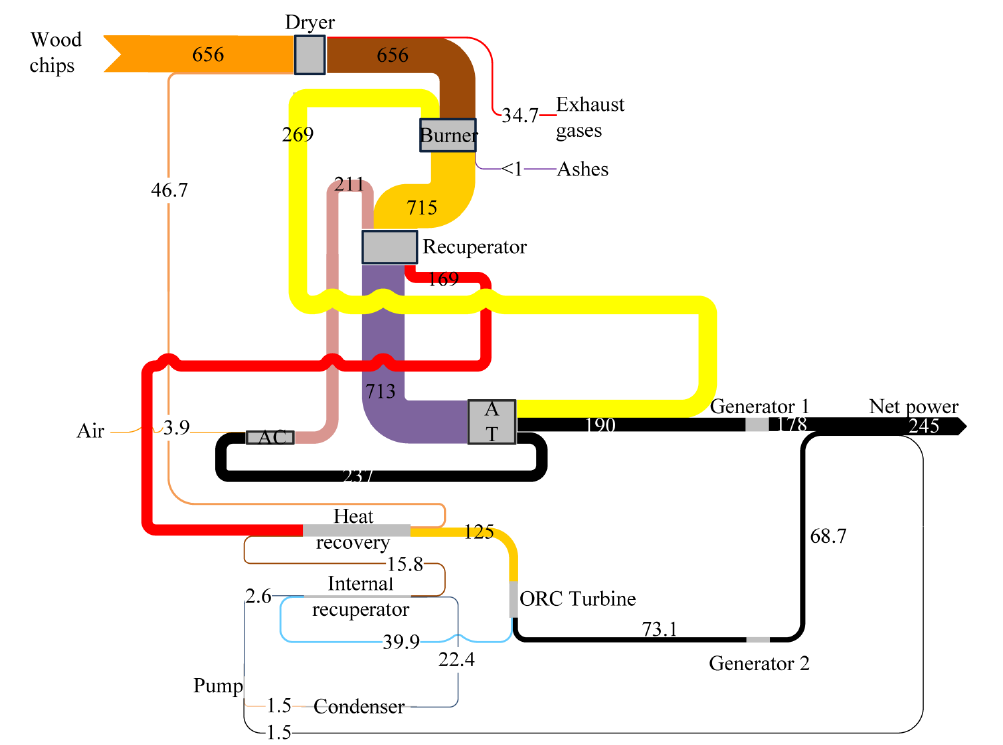
Figure 5. Grassmann diagram of the optimal plant design. The compressor pressure ratio is 5.5. The working fluid circulating in the ORC module is toluene with a turbine inlet pressure of 20 bar. Exergy flows are expressed in